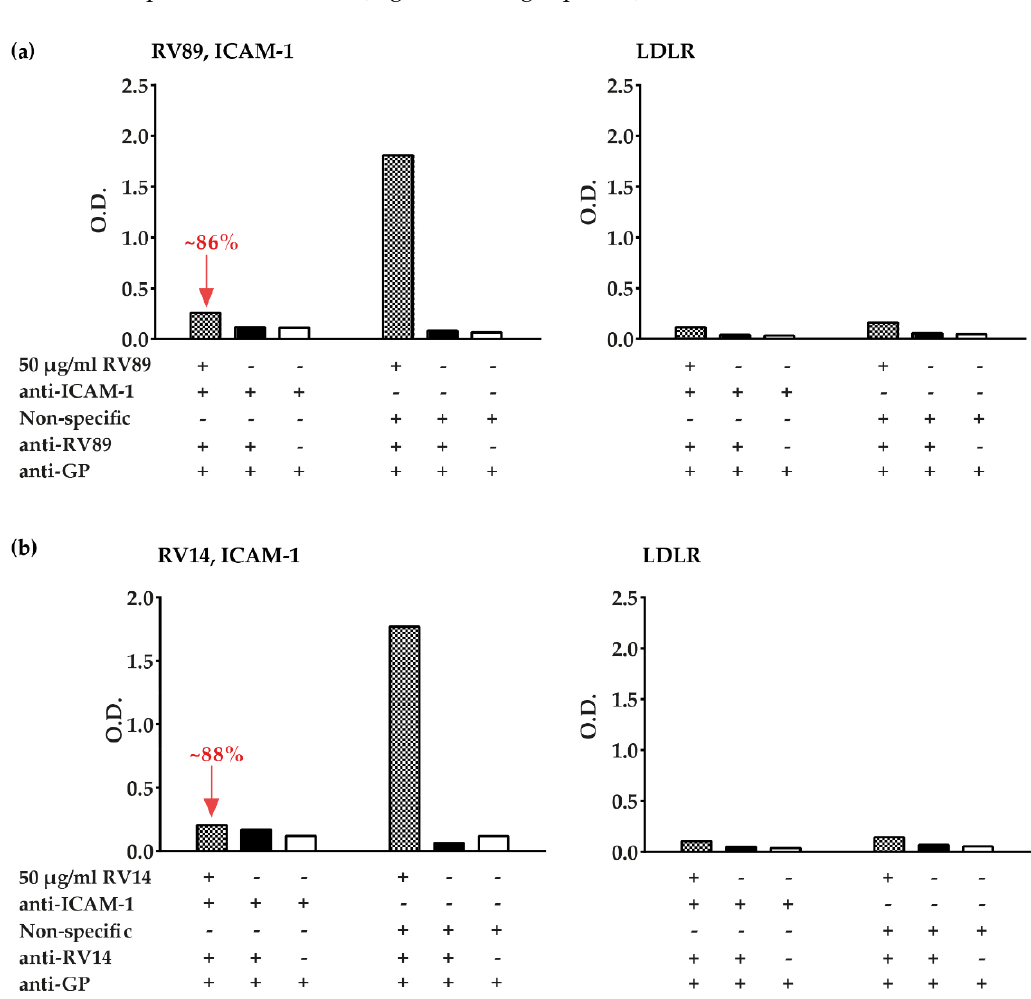
Figure 4. Inhibition of RV89 and RV14 binding to plate-bound receptors by receptor-specific antibodies. Binding of RV89 (upper part) ( a ) and RV14 (lower part) ( b ) to plate-bound ICAM-1 (left panels) or plate-bound LDLR (right panels) is reported as mean O.D. values (y-axes) in the presence ( + ) or absence ( − ) of virus, anti-ICAM-1 antibodies, non-specific antibodies, anti-RV detection antibodies, and secondary detection antibodies (anti-GP) (below x-axes). The percentage inhibitions of RV89 binding and RV14 binding obtained with anti-ICAM-1 antibodies versus non-specific antibodies are indicated in red. The results are means of duplicate determinations with a variation of less than 10%. Inhibition experiments were repeated three times.